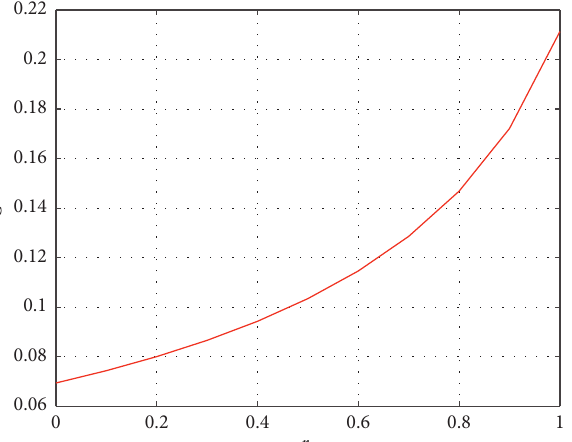
Figure 20: Effect of unit residual value r